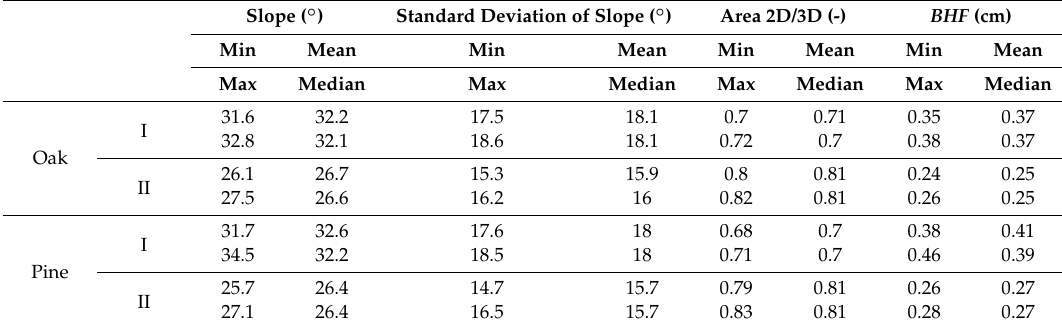
Table 3. Characteristics of the surfaces of tree trunks studied. Slope ( ◦ ) Standard Deviation of Slope ( ◦ ) Area 2D/3D (-) BHF